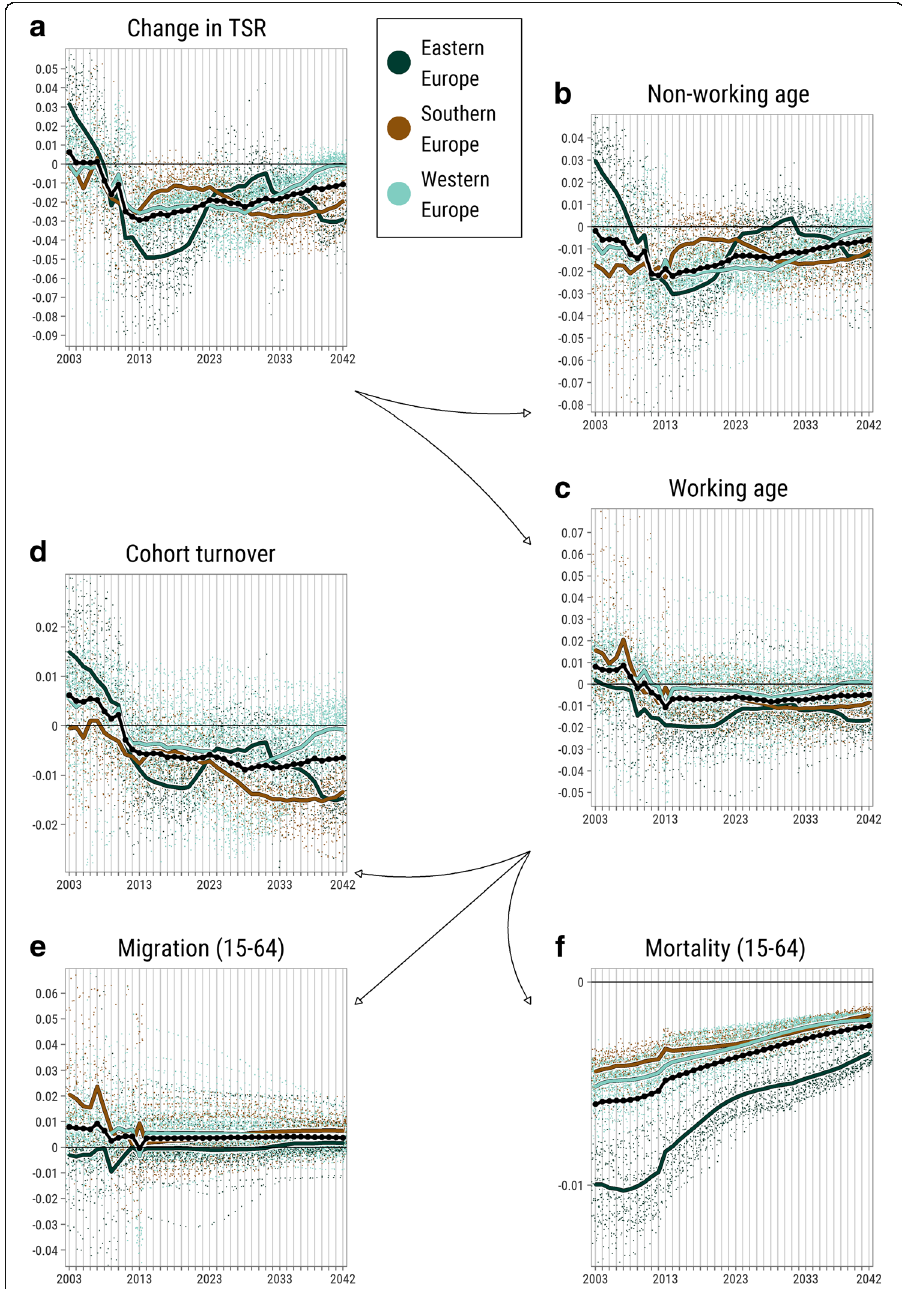
Fig. 4 a – f Distributions of the decomposed components of change in TSR, all years between 2003 and 2043. Notes : Each NUTS-2 region is represented with a point colored according to EuroVoc definition of European subregion. Scales on y -axes are panel specific due to the big difference in variables ’